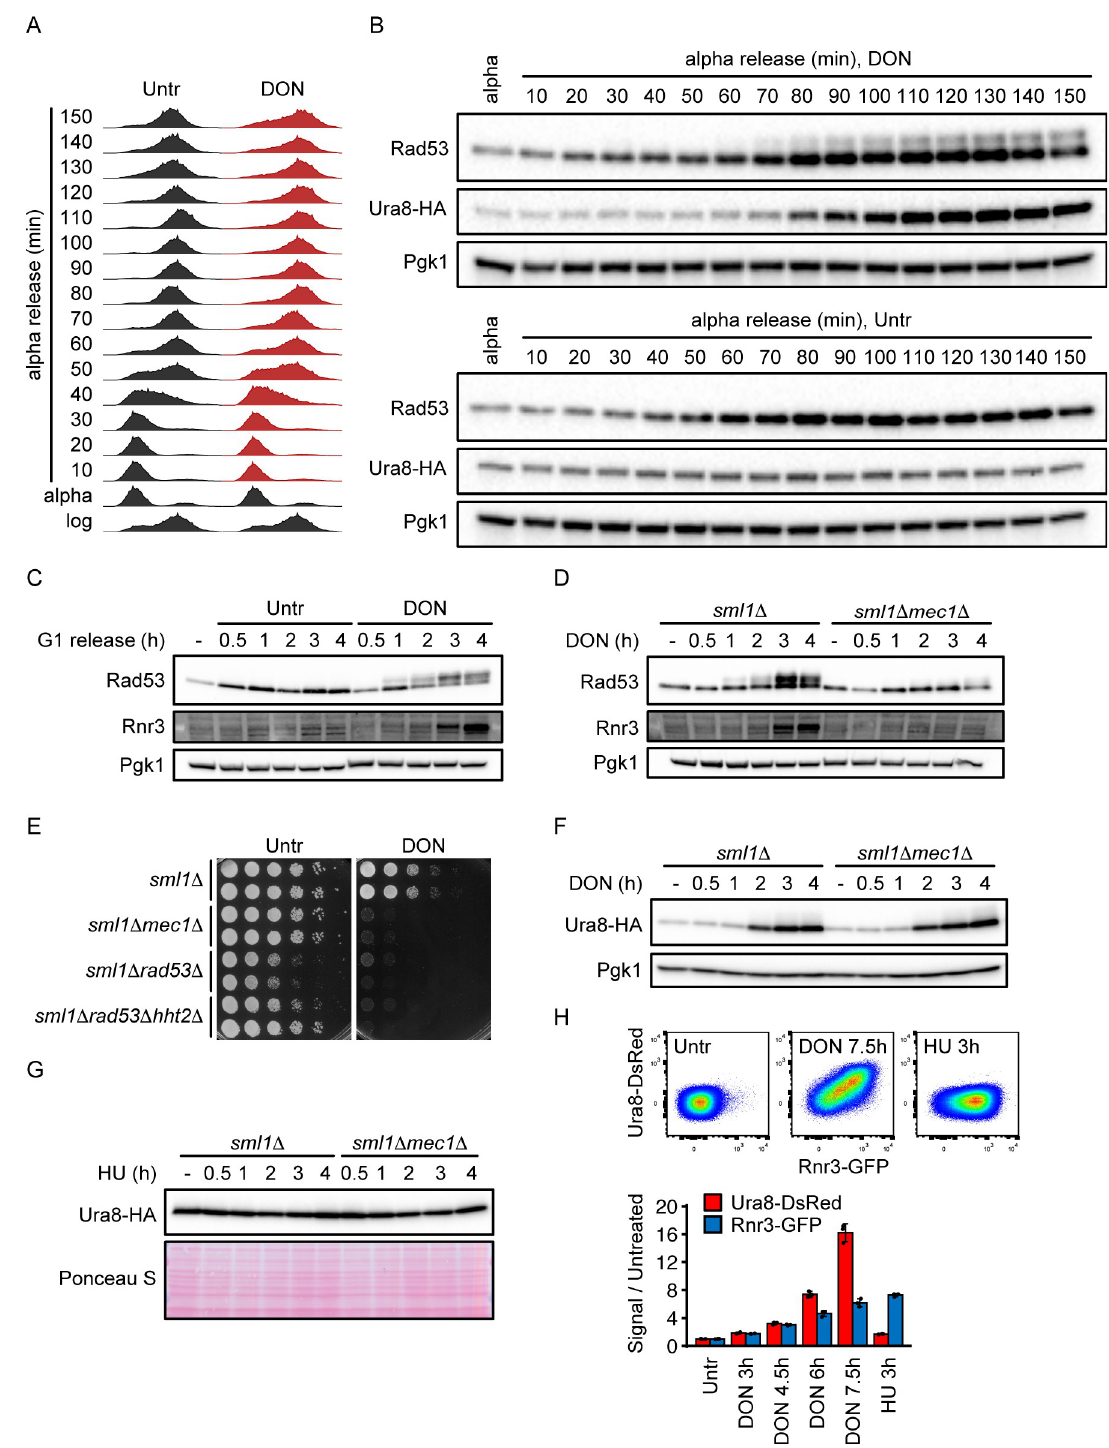
Fig 3. DDR and CTP synthase mediate independent layers of the glutamine analog response. (A) Cells of the indicated genotypes were arrested in G1 phase with α -factor, released into YPD with or without 300 μ M DON and fixed in 70% ethanol at the indicated time points. DNA content was analyzed by flow cytometry. (B-C) Cells expressing endogenous HA-tagged Ura8 (B) or wildtype cells (C) were arrested in G1 phase with α -factor and released into YPD with or without 300 μ M DON. Cells were fixed in TCA at the indicated time points and proteins were analyzed by Western blot. (D) Cells of the indicated genotypes were arrested in G1 phase with α -factor, released into YPD with 300 μ M DON and fixed in TCA at the indicated time points. Proteins were analyzed by Western blot. (E) 10 7